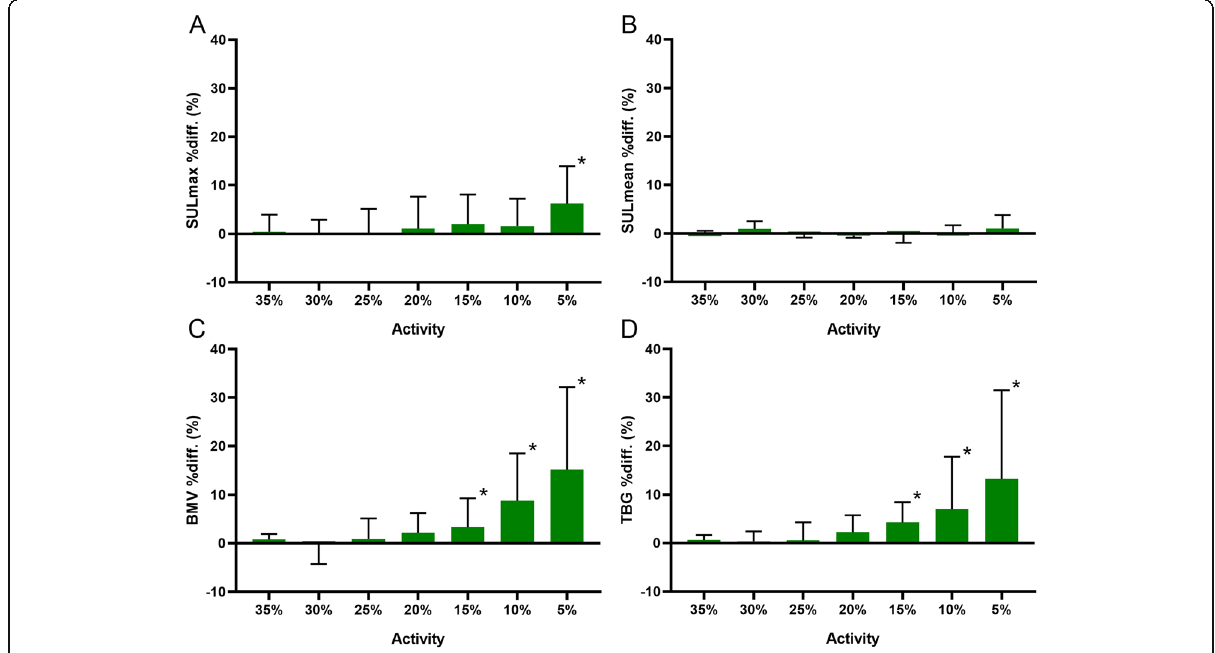
Fig. 4 Supraclavicular BAT values for multiple simulated activities. The graphs show the SUL max ( a ), SUL mean ( b ), BAT metabolic volume (BMV) ( c ), and total BAT glycolysis (TBG) ( d ) percentage difference (%diff.) values in relation to the corresponding 4-min reference scan. Results are reported as median ± interquartile range. An asterisk indicates a significant difference with the